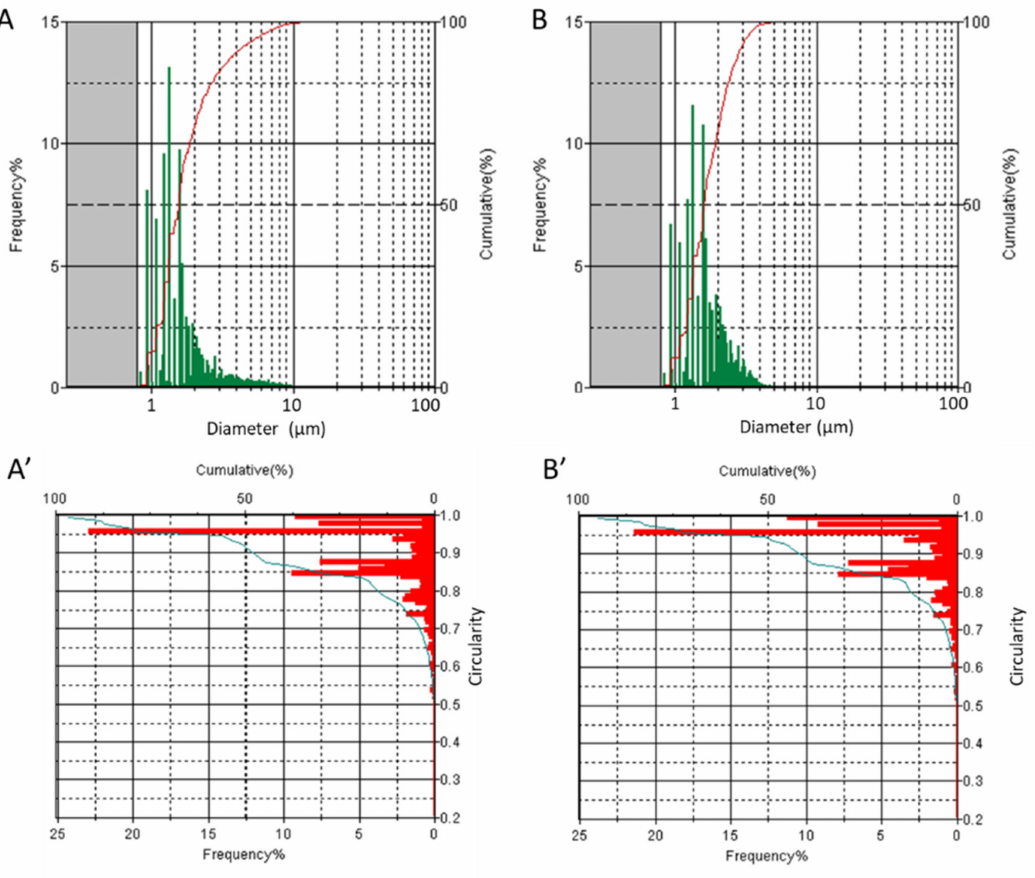
Figure 2. Particle size and shape distribution evaluated by flow particles images analyser (FPIA). Particle size distribution (frequency and cumulative) of ( A ) Ti-PS and ( B ) Ti-PR; circularity (frequency and cumulative) of ( A’ ) Ti-PS and ( B’ )